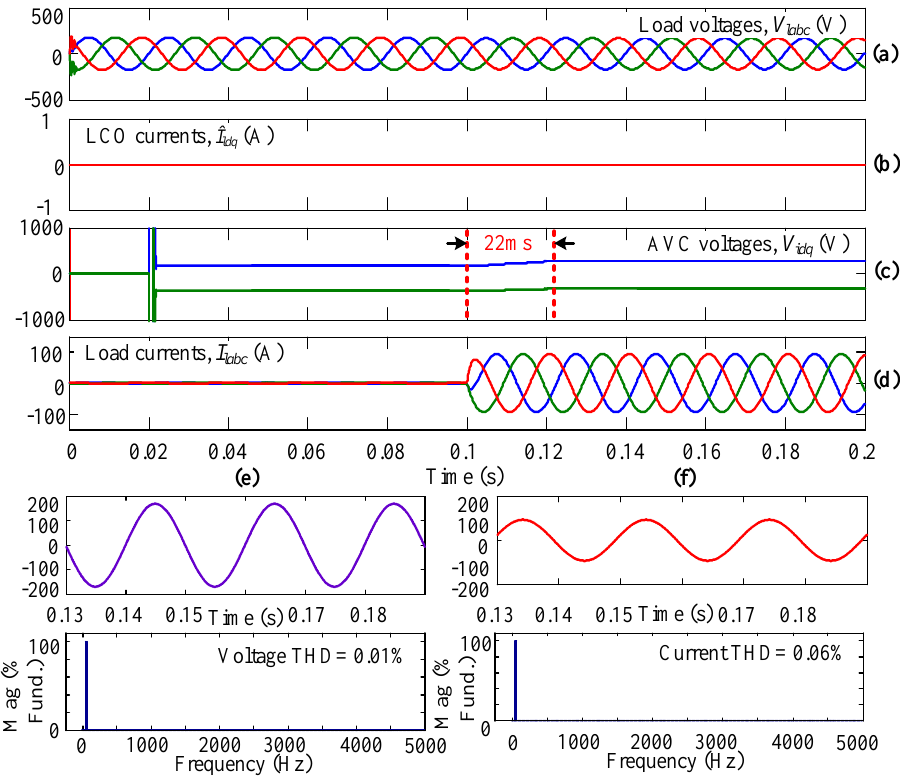
Figure 5. Simulation results for case-I with balanced load condition.